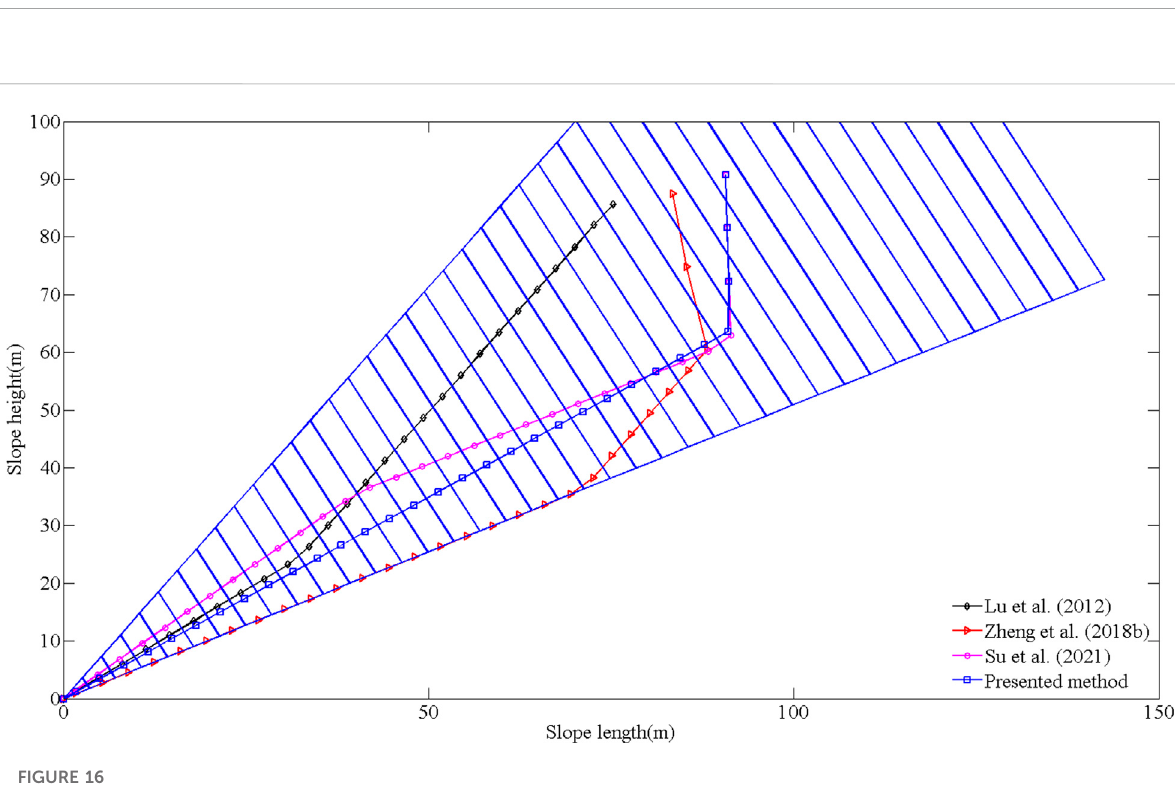
the stability factor are listed in Table 5. The failure depths of rock layers h i , the external forces prompting the rock layers to undergo shear sliding failure P i , the external forces prompting the rock layers to undergo fl exural toppling failure T i , and the slope failure surfaces,